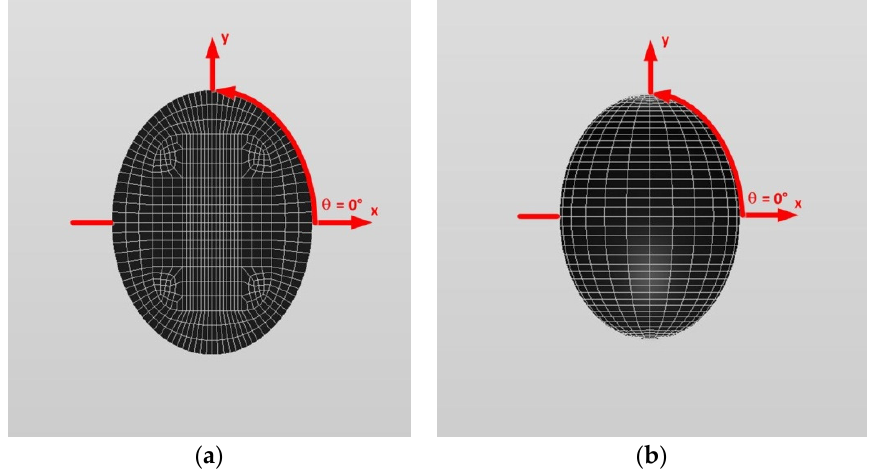
Figure 11. A typical discretized prolate spheroidal model (a/b = c/b = 0.75) in the volume integral equation method (VIEM). ( a ) An inside view of a prolate spheroidal model. ( b ) A prolate spheroidal model.